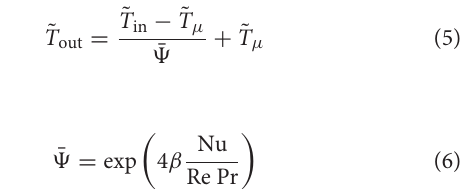
FIGURE 4 | ˜ C out as a function of Re /β , for various β , with ˜ C in ˜ C µ = 1. Dots: results of the CFD simulations of Supplementary Equations 3–13 in the Supplementary Material . Full line: results obtained using Equations (2), (3), and